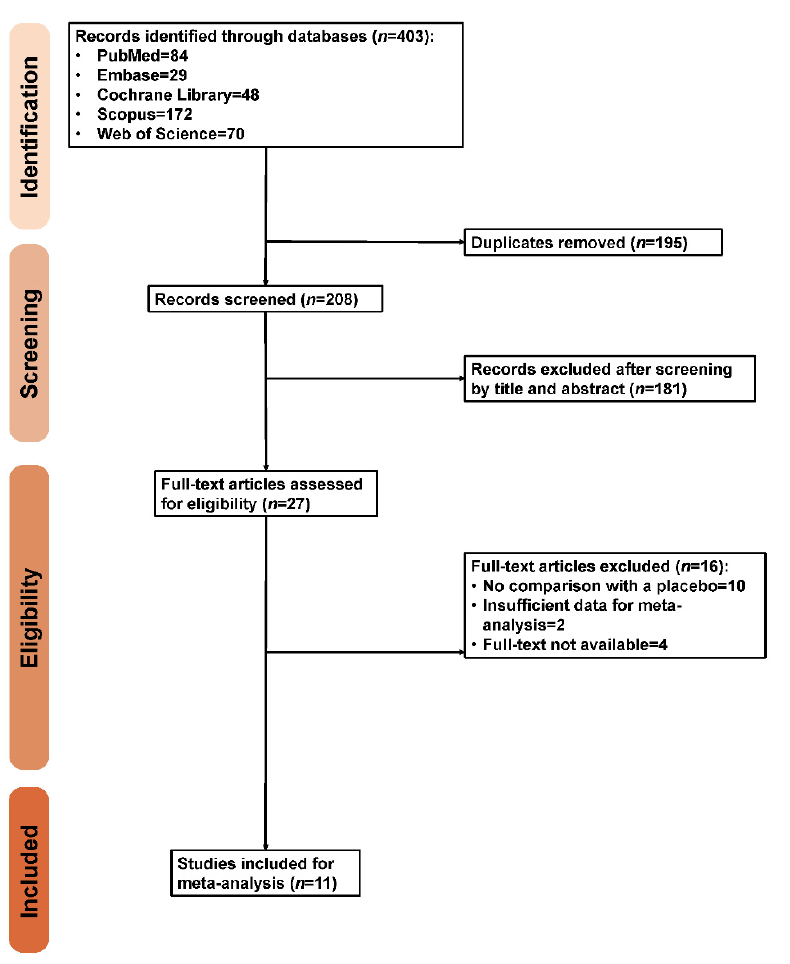
Figure 1. Preferred Reporting Items for Systematic Review and Meta-analysis (PRISMA) flow diagram.